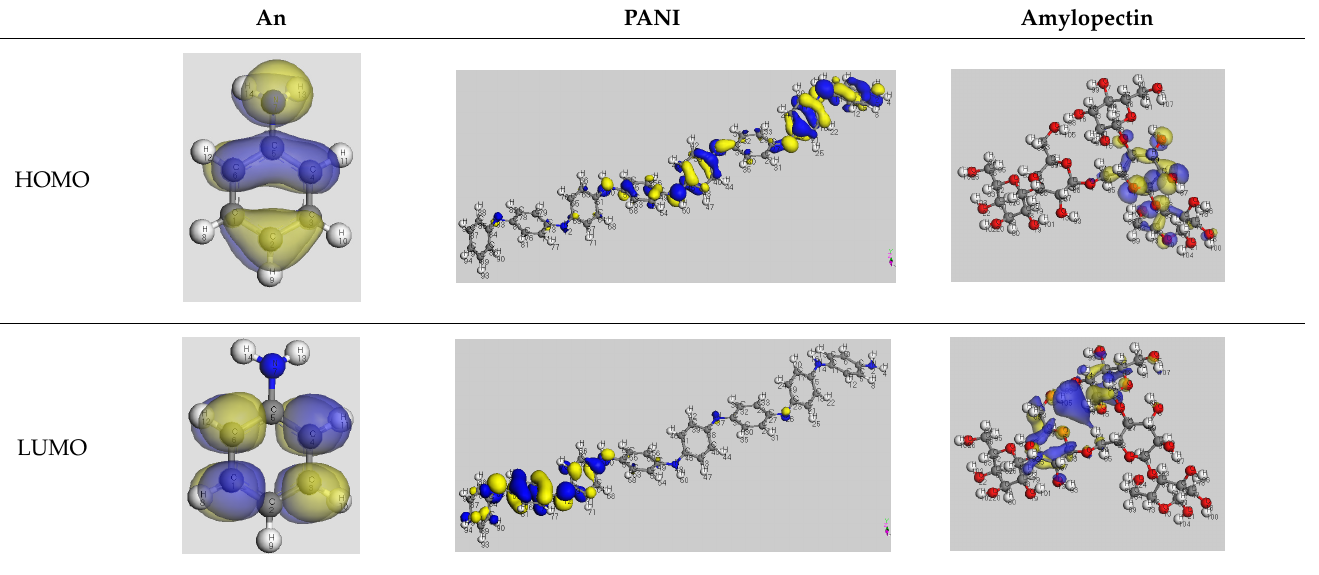
Table 11. Fukui analysis of aniline, polyaniline, and amylopectin: The nucleophilic term f_k^+; the electrophilic term f_k^- values of the Fukui function.